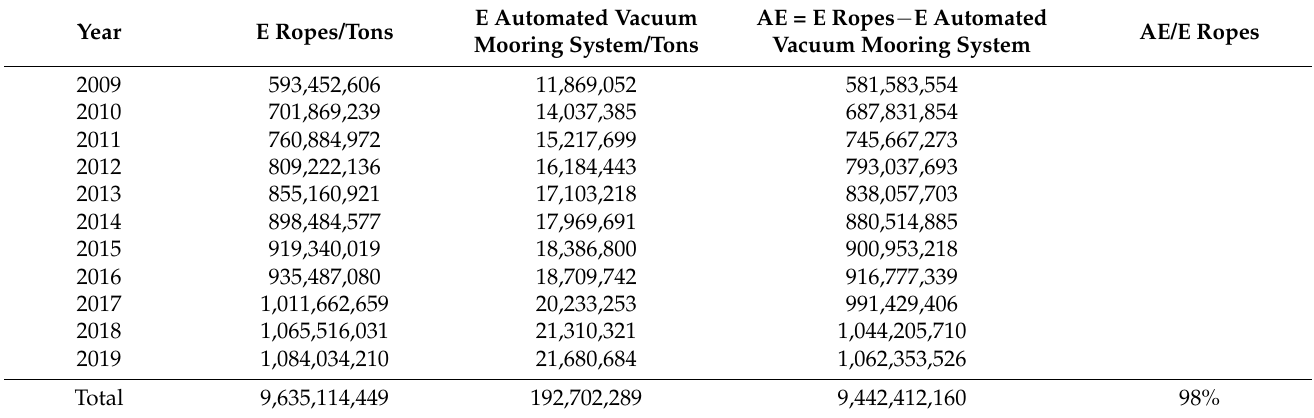
Table 2. Emissions of CO 2 from 2009 to 2019 (adapted with permission from Ref. [34]. Copyright 2021 D í az-Ruiz-Navamuel, E.).